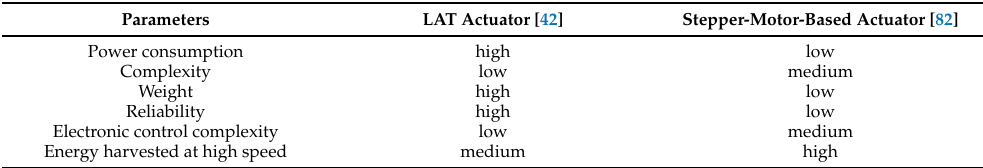
Table 4. Comparison of the wind turbine actuators.